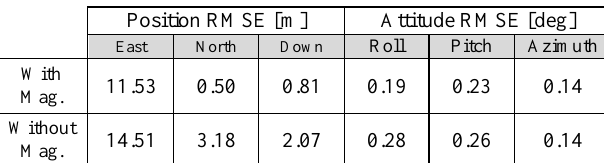
Table 4. ADIS PA RMSE for magnetometer aiding using RTK position and velocity update